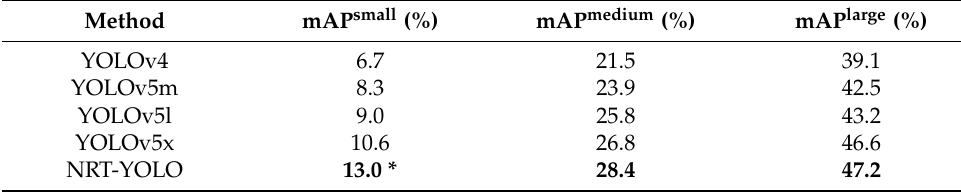
Table 2. Comparison results of COCO evaluation.